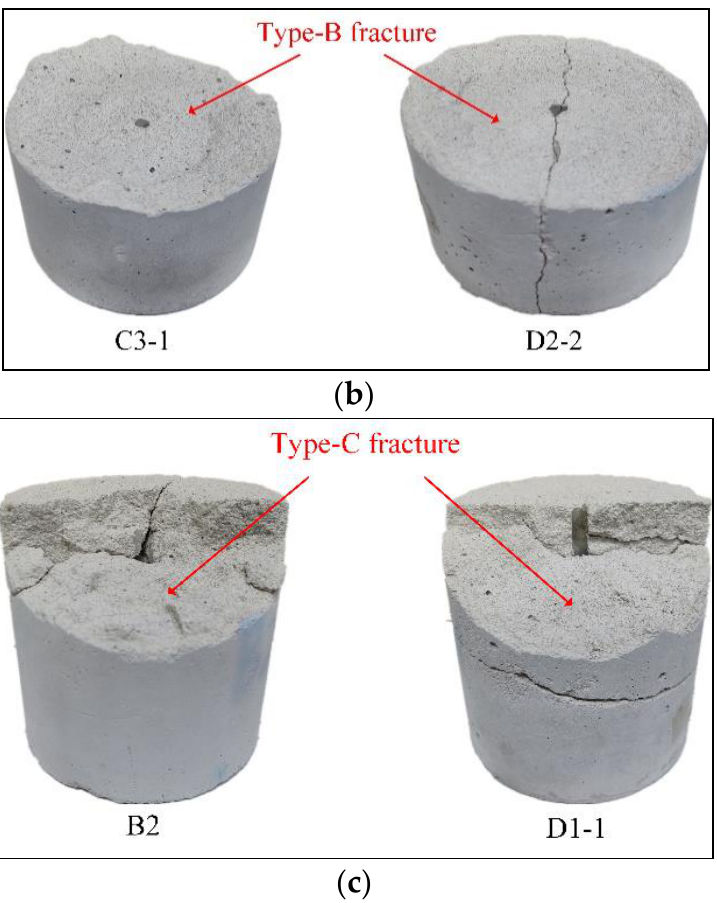
Figure 6. The different types of main fractures. ( a ) Type-A, longitudinal fracture; ( b ) type-B, trans- verse fracture; ( c ) type-C, oblique fracture.